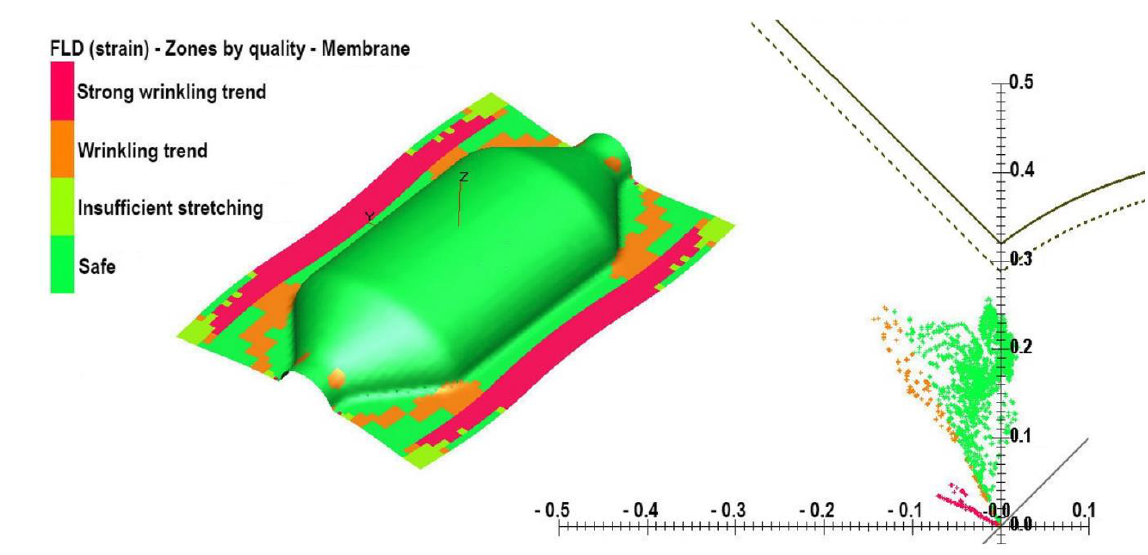
Figure 2. Prediction of catalytic converter manufacturability by numerical simulation.